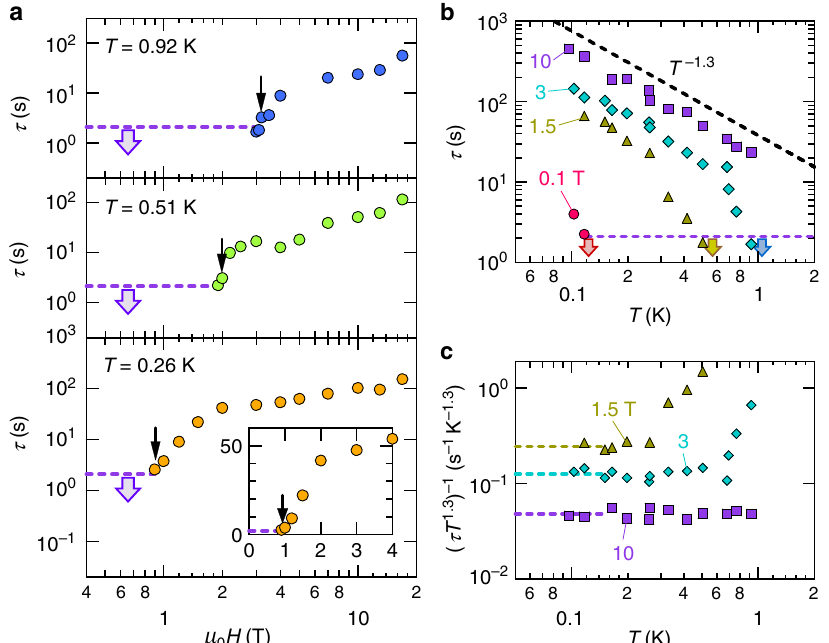
Fig. 2 Magnetic fi eld and temperature dependence of the relaxation time. a Magnetic- fi eld dependence of the relaxation time, τ , for the spin heating at various temperatures. The dashed line represents constant τ of 2.1 s. At low fi elds, τ is shorter than 2.1 s (thick arrows). The thin arrows indicate the onset fi eld of the τ increase, H *, which is determined based on the linear-scale plot, shown in the inset. b Temperature variation in τ for the spin heating at various magnetic fi elds. The black- and purple-dashed lines denote the power-law behavior with an exponent of − 1.3, and constant τ of 2.1 s, respectively. At each fi eld, τ is shorter than 2.1 s above the temperature indicated by the thick arrows. c Temperature dependence of ( τ T 1.3 ) − 1 at various magnetic fi elds. The dashed line represents a zero-temperature extrapolation of the low-temperature data, ð τ T 1 : 3 Þ (cid:2) 1